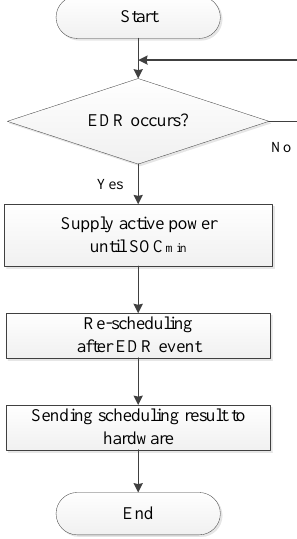
Figure 4. Flow chart of BESS real-time algorithm.